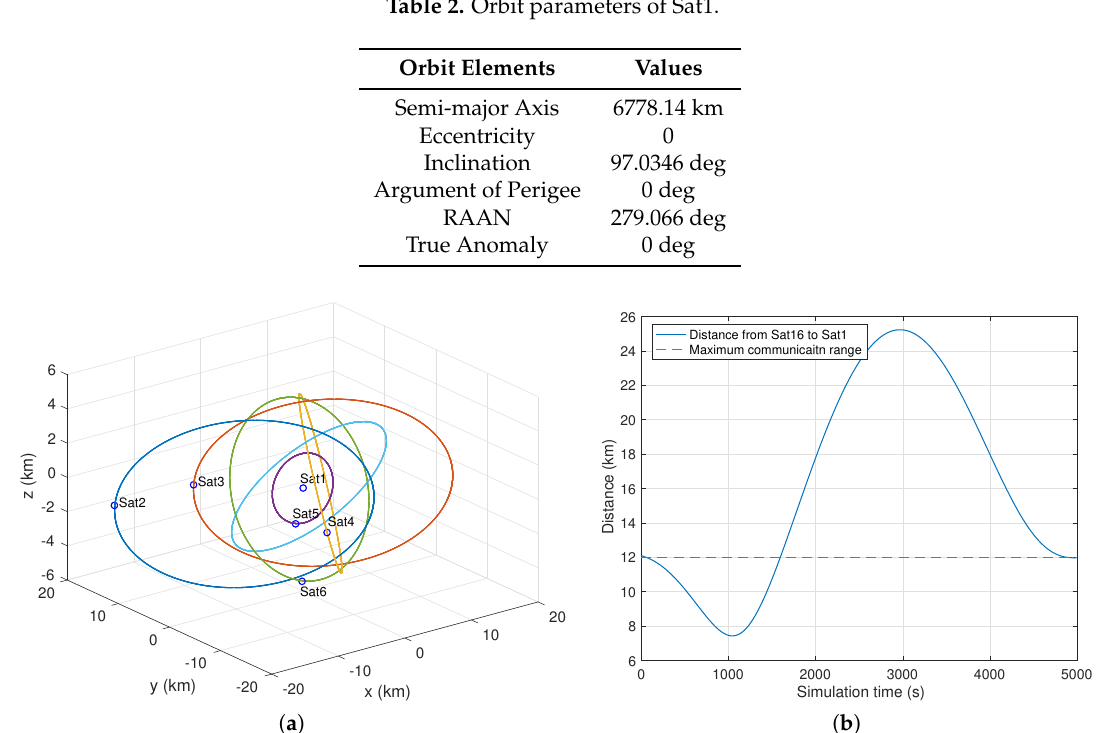
Figure 6. Illustration of the satellite cluster simulation scenario showing the trajectories of Sat2-6 moving with Sat1 ( a ) and distance varying with time from Sat16 to Sat1 ( b